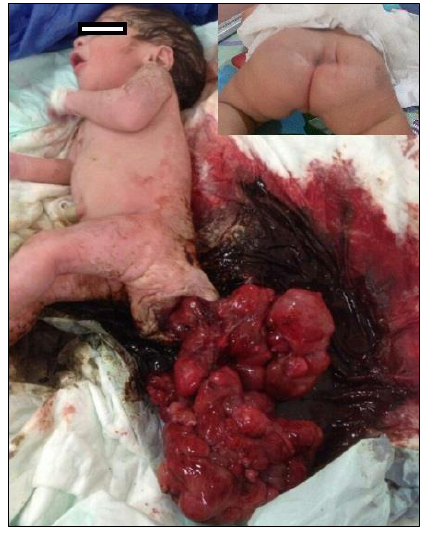
Figure 1: Showing ruptured SCT. Inset showed healed scar at 6-month follow-up. Tumor rupture may be caused by uncontrolled labor or complications during delivery [1]